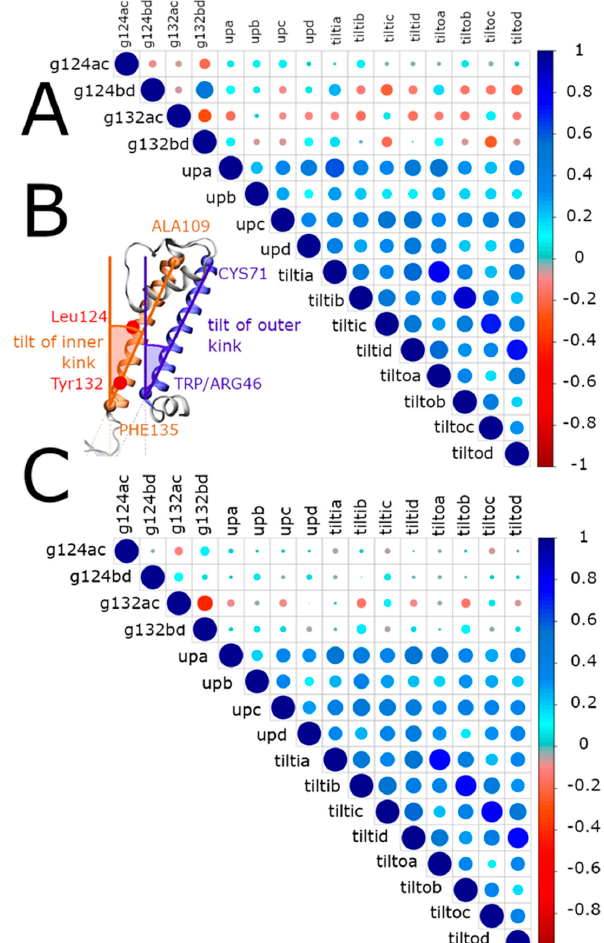
Figure 6. Correlation between the gating and the upward movement of the slide helices and incli- nations of the transmembrane helices in KirBac3.1 W46R. ( A ) Correlations in the W46R mutant. The shortest distance between the residues L124 belonging to the chains A and C defining the gating at this level is denoted g124ac, and similarly, for Y132, it is designated g132ac. The upward movement of the slide helices of the chains A, B, C and D are denoted upa, upb, upc, upd, respectively. The tilt angle of the axes of the inner and outer helices from the perpendicular line to the membrane plane are denoted tiltin and tilton, respectively, where n is the name of the chain. Blue and red circles correspond to positive and negative correlations, respectively. The diameter and the color intensity of a circle are proportional to the strength of the correlation. ( B ) Definition of the inner and outer tilts (brown and blue, respectively). The upward movement of the slide helices is defined as in Figure 5B Constrictions points L124 and Y132 are shown. ( C ) Correlations in the case of KirBac3.1